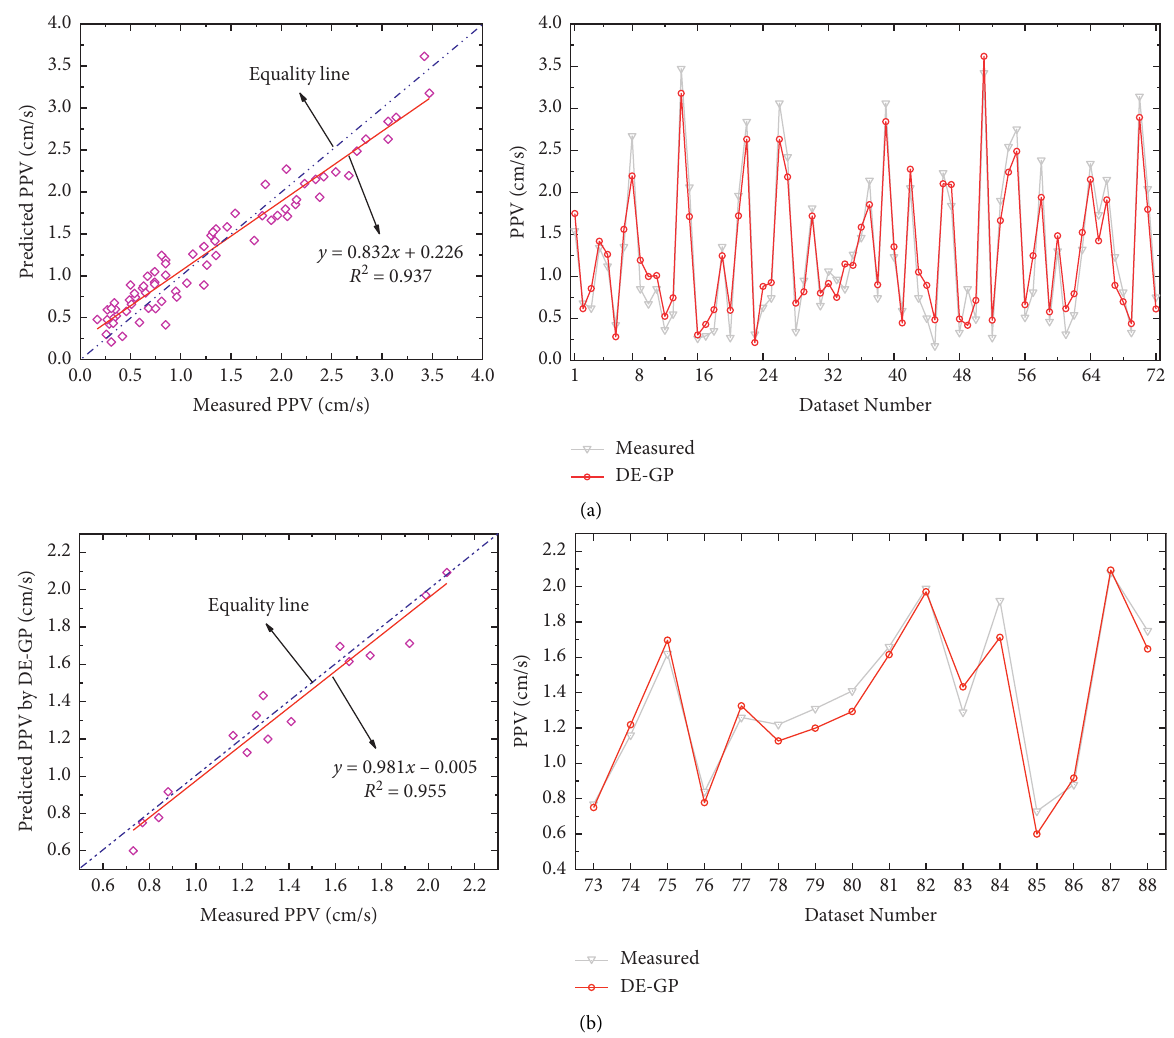
Figure 7: Analysis and comparison of the measured PPV and the predicted PPV by the DE-GP model in the training phase and the test phase. (a) Training phase. (b) Test